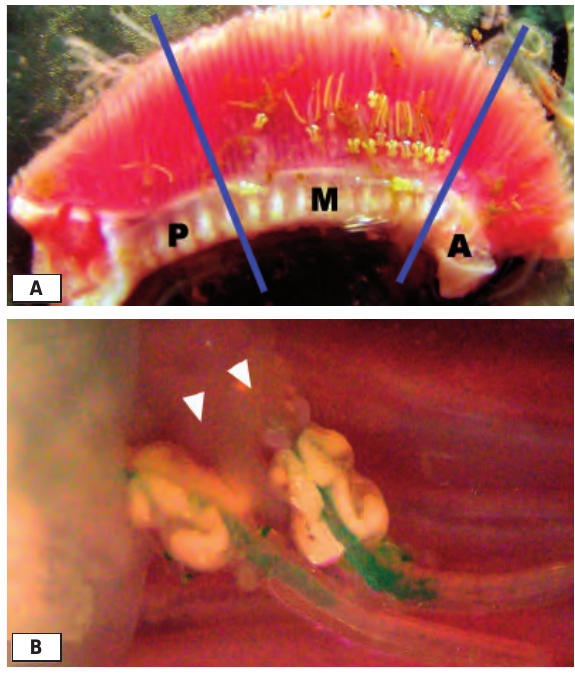
A (A) Photograph of a gill arch of Labeobarbus polylepis to indicate attachment sites of Lamproglena hoi para- sites. Gill is divided into three sites (anterior (A), medi- an (M) and posterior (P)), and (B) an enlargement to show attachment and proliferation at attachment site. Arrows indicate proliferation